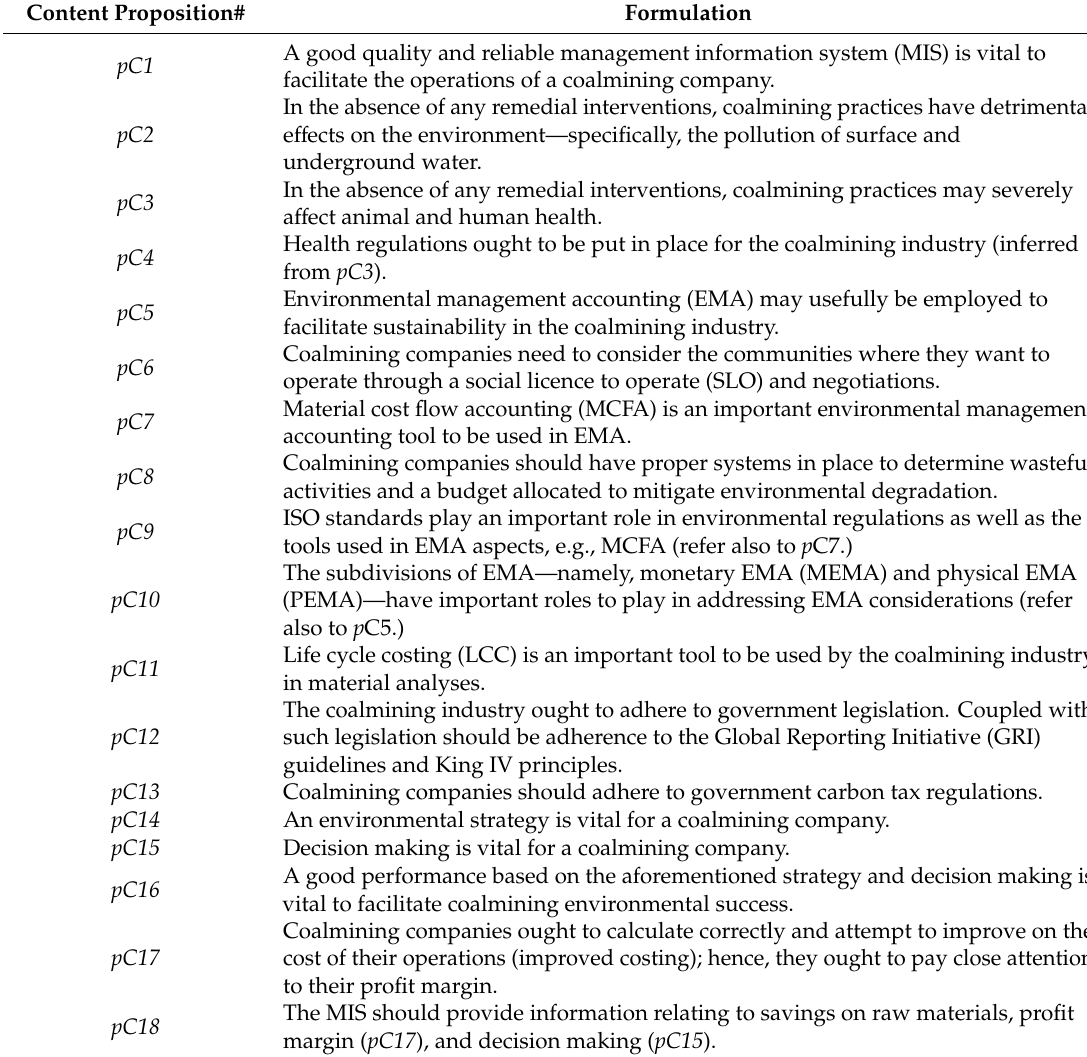
Table 2 indicates the content propositions that emerged from the literature. Table 2. List of content